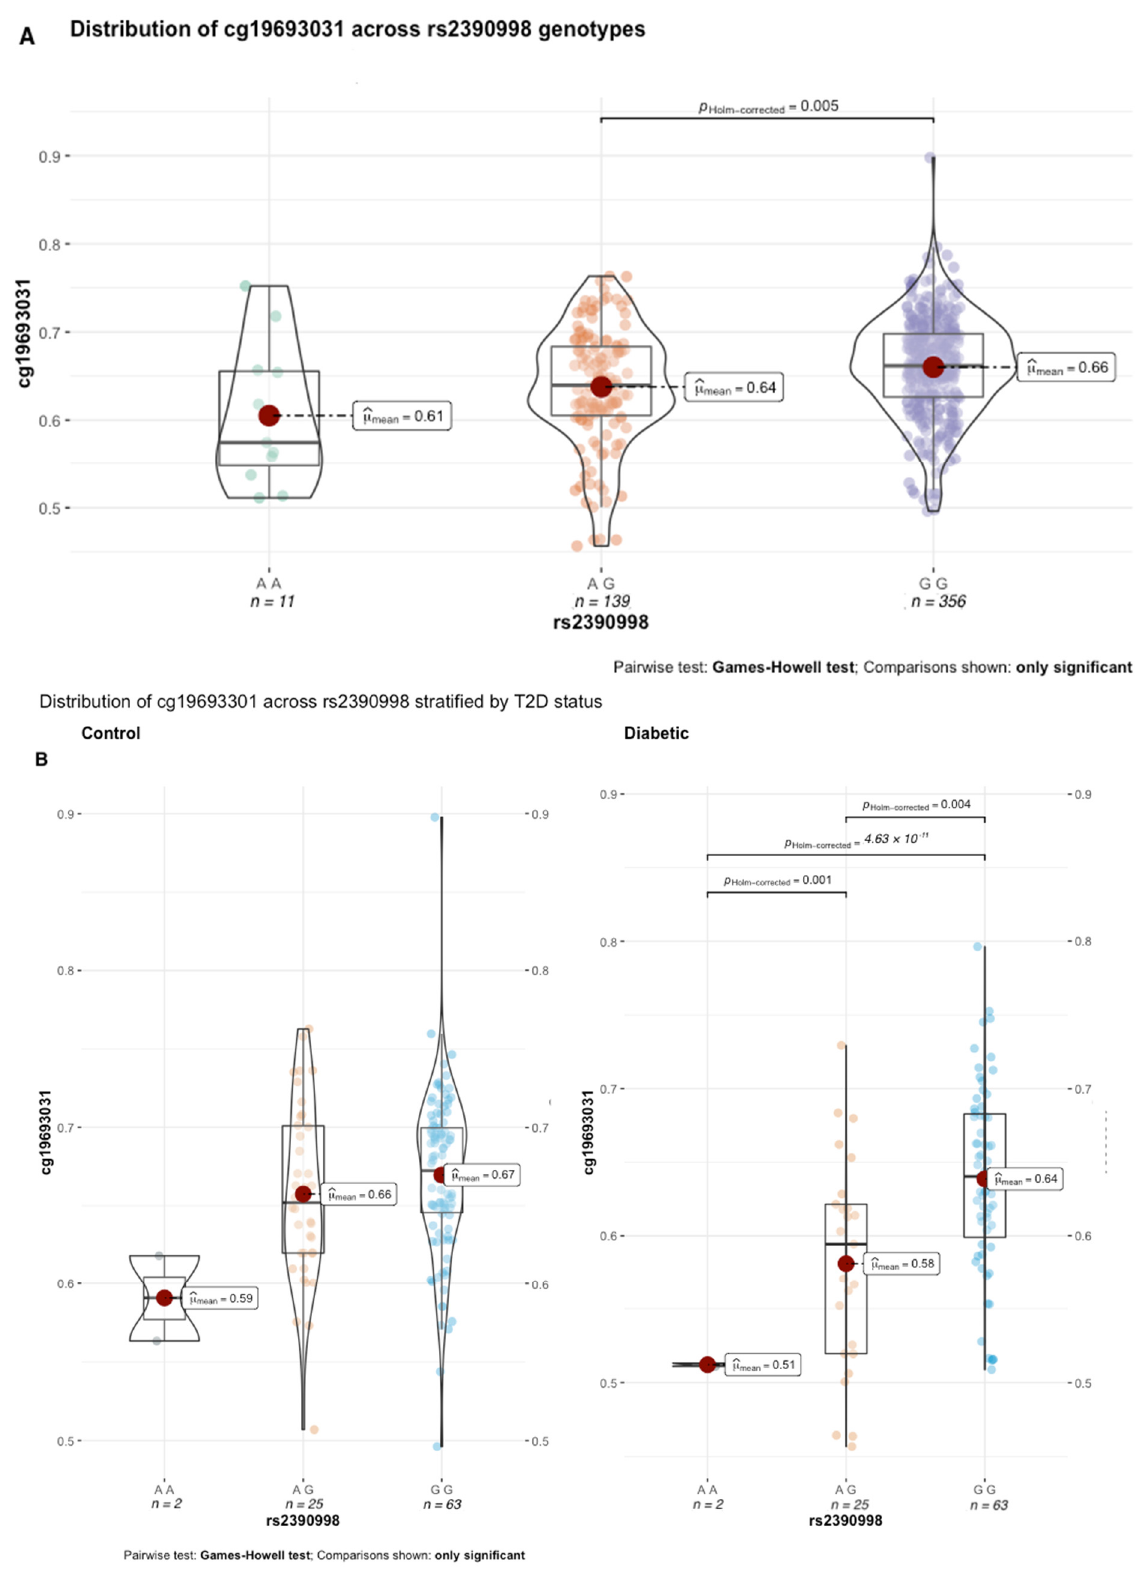
Figure 6. cg19693031 distribution as a function of rs2390998 genotype across all 506 subjects ( A ) and stratified by T2D status ( B ).